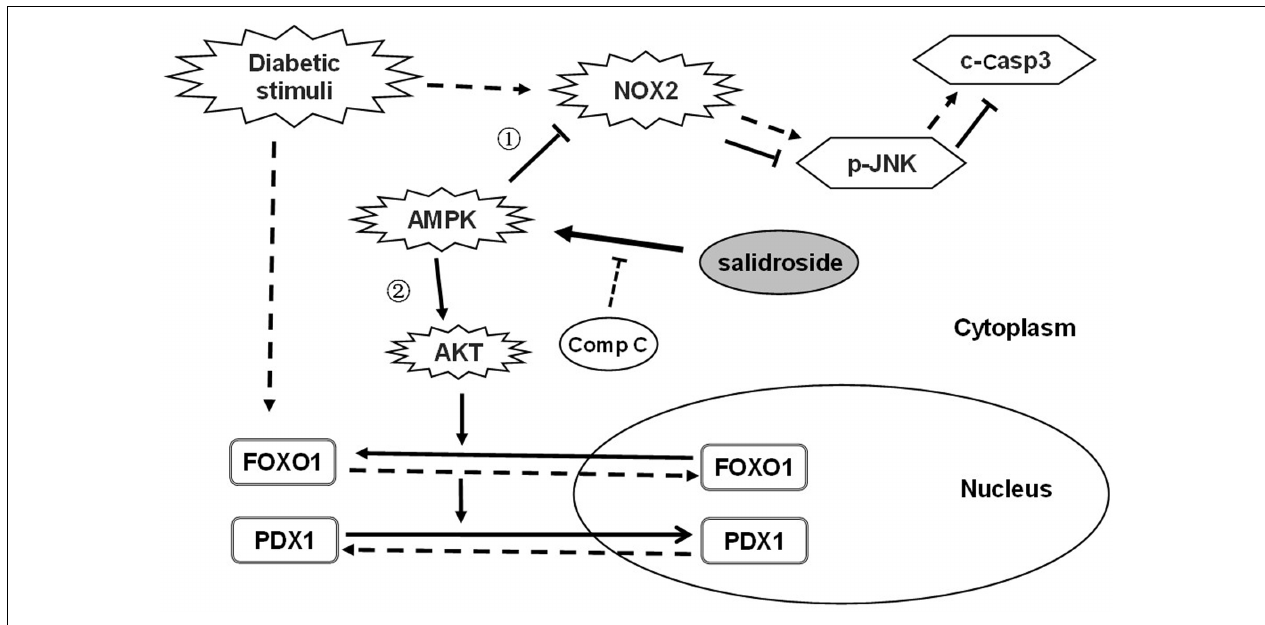
FIGURE 6 | Proposed action pathway of salidroside in preventing β -cell failure under diabetic oxidative stress. Straight line arrow ( −→ ) represent actions of salidroside and dotted line arrow ( (cid:57)(cid:57)(cid:75) ) represent actions of diabetic